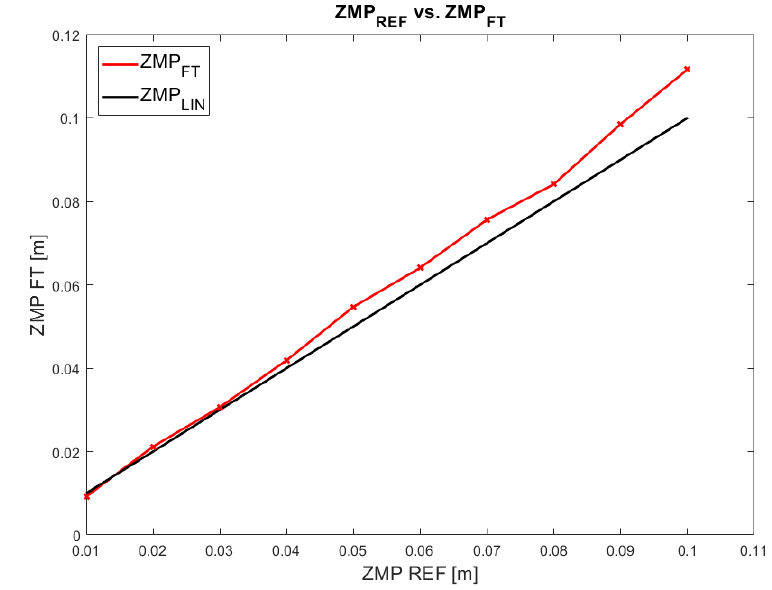
Figure 16. Comparison of experimental ZMP ref − ZMP F − T steady state values.